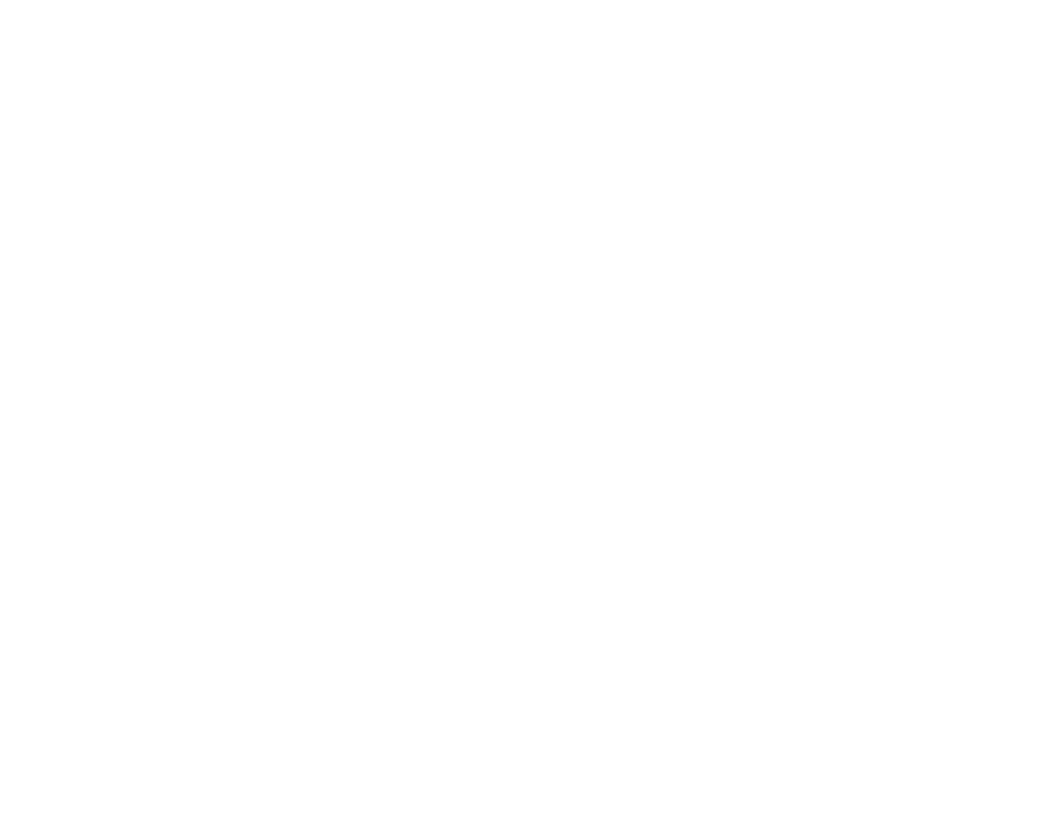
FIGURE A1 | Time course of BOLD responses in bilateral medial occipital cortex. The time course of each given condition from each given ROI was calculated as the mean response ( ± SEM) across all sessions and subjects as determined by FIR modeling (Method 1; Materials and Methods). During the strong clutter and weak clutter conditions, the correct response was a “Target Present” report,